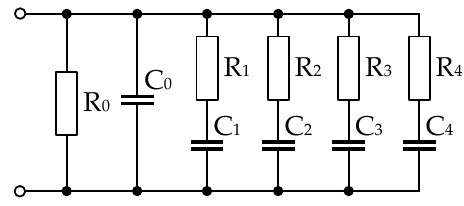
Figure 15. Valsa RC circuit to emulate FO capacitor.